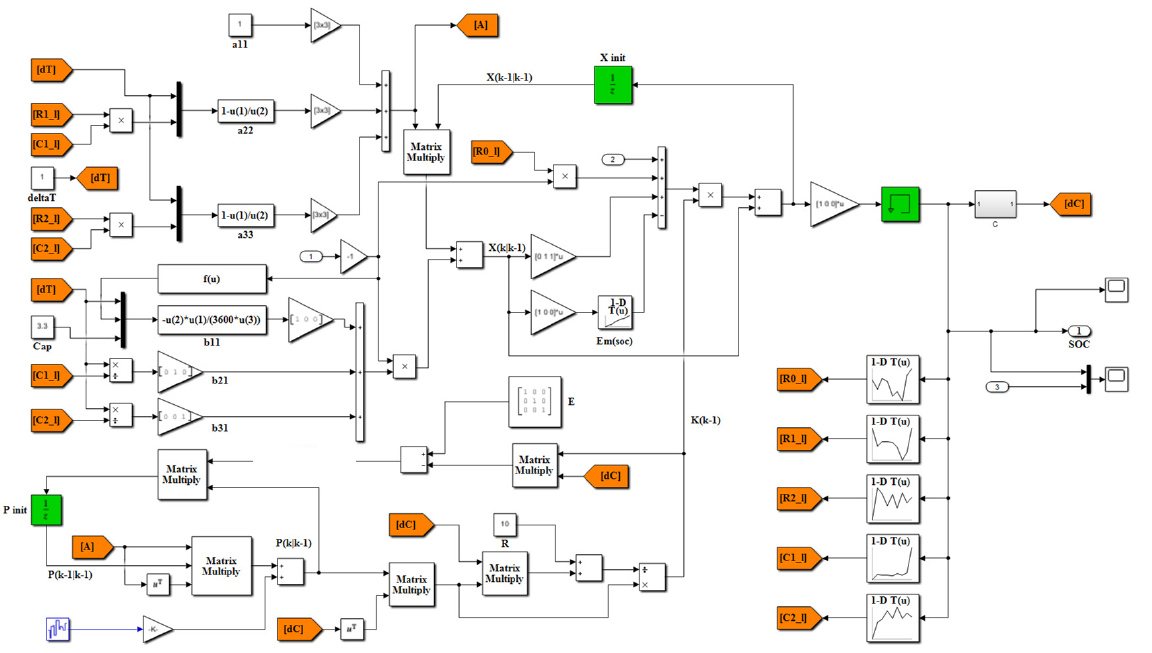
Figure 7. Block diagram of Simulink for the SOC estimation of the lithium-ion battery using EKF.